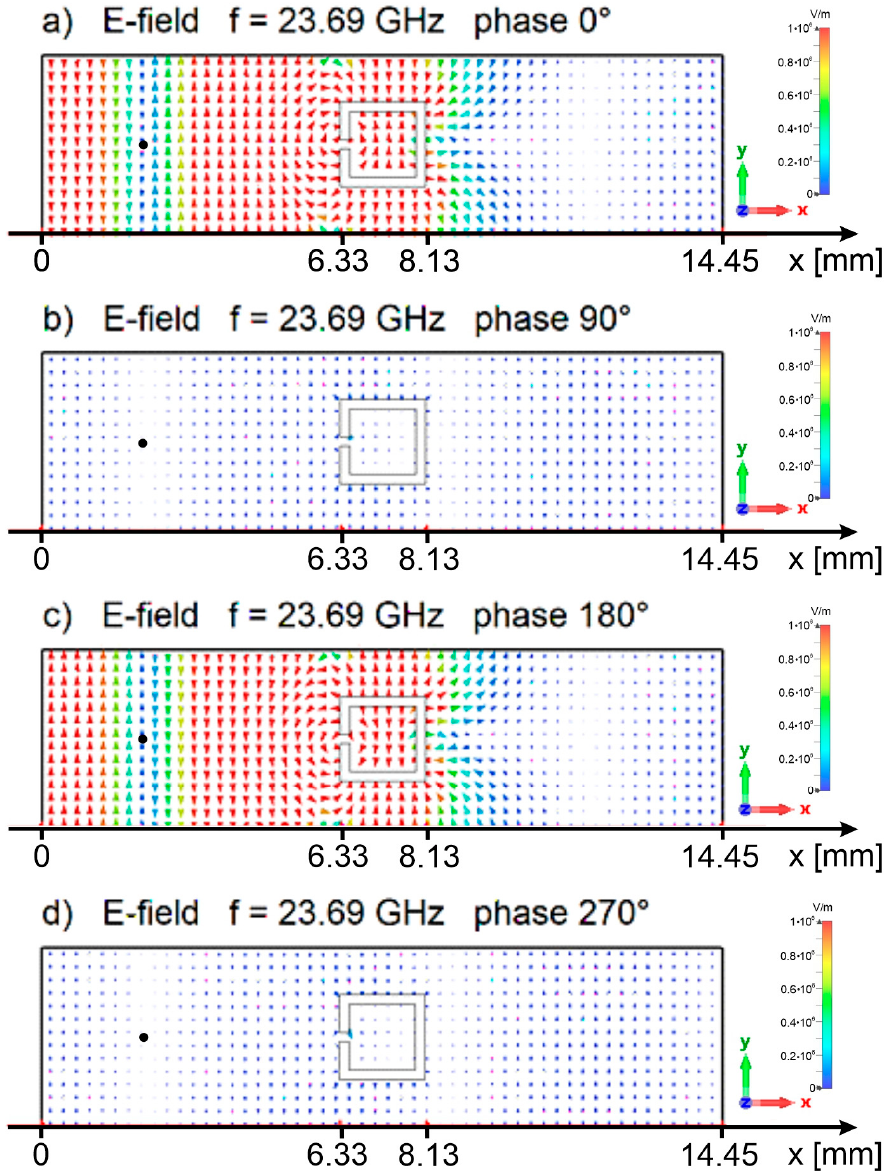
Figure 6. Distribution of the electric field E in the cross-sections xy for z = − 1.6 mm at f = 23.69 GHz corresponding to the magnetic resonance. The plane electromagnetic wave propagates in the +x axis: ( a ) Phase 0 ◦ ; ( b ) phase 90 ◦ ; ( c ) phase 180 ◦ ; ( d ) phase 270 ◦ . Black points, the nodes of the standing